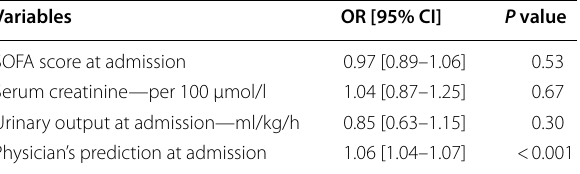
Table 3 Physician’s prediction of need of RRT at